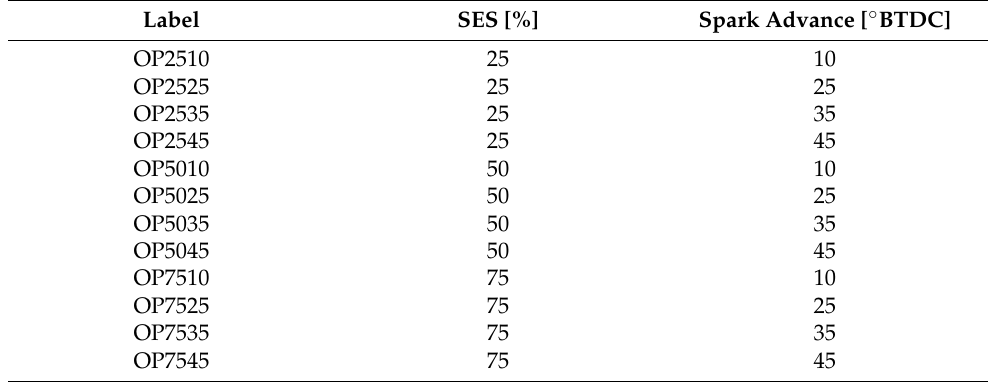
Table 5. Definition of the 12 operating points based on their: label, SES, and spark advance. Label SES [%] Spark Advance [ ◦